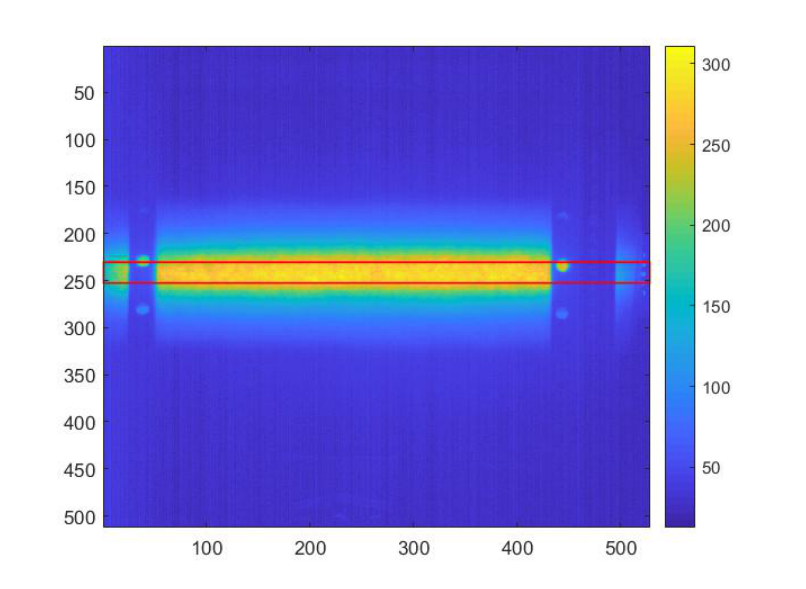
Figure 7. Representation of the heated region with a temperature above 250 ◦ C. A width of 1.13 cm is calculated using a Matlab ®